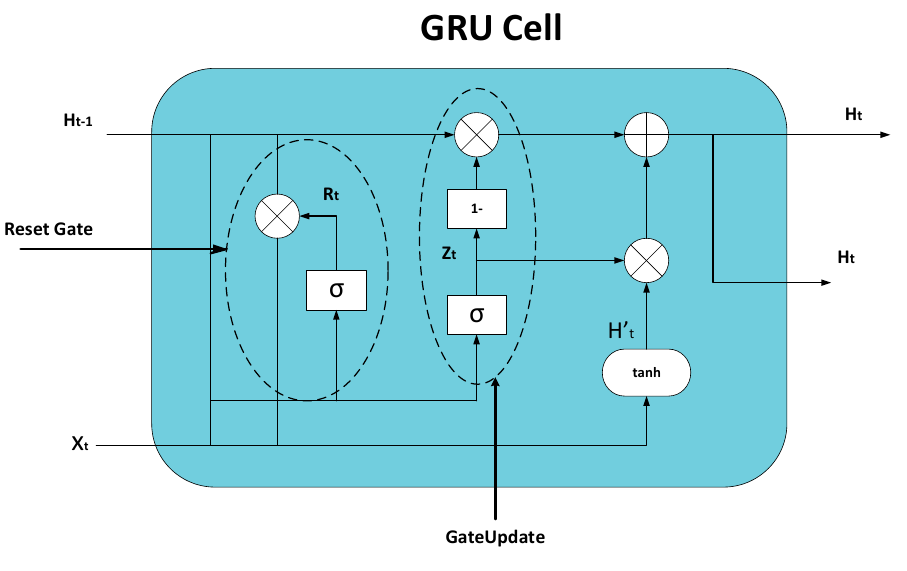
Figure 7. Internal structure of GRU.